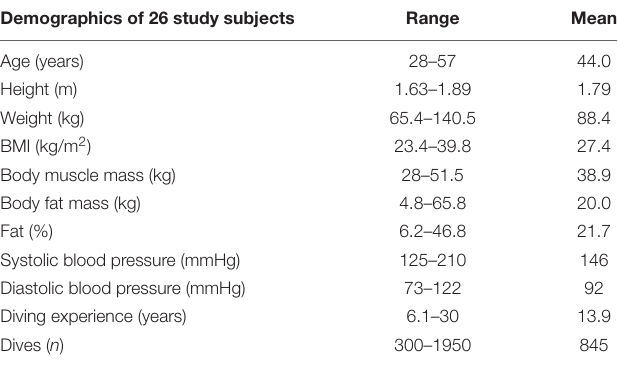
TABLE 1 | Demographics of 26 study